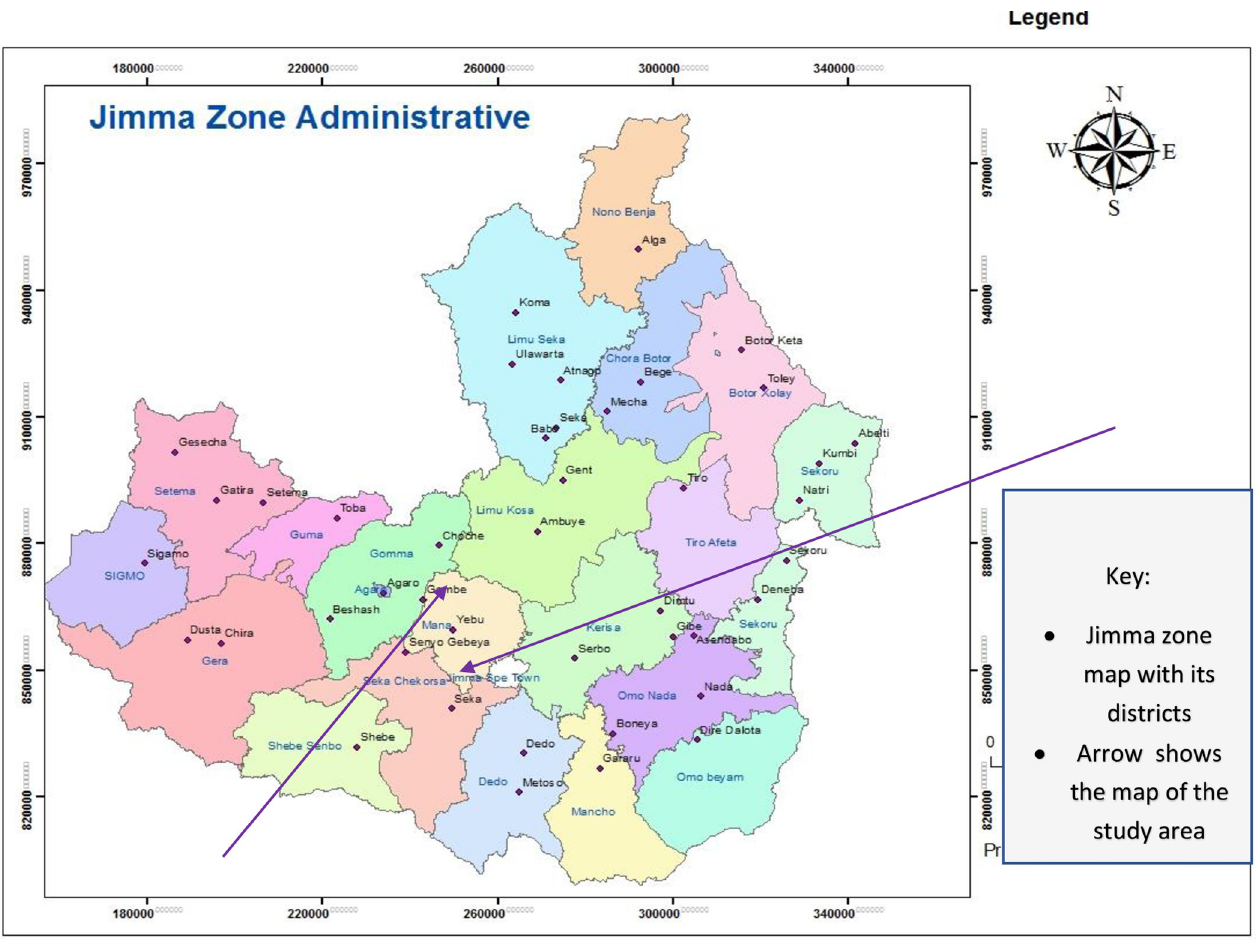
Fig 1. Map of the study